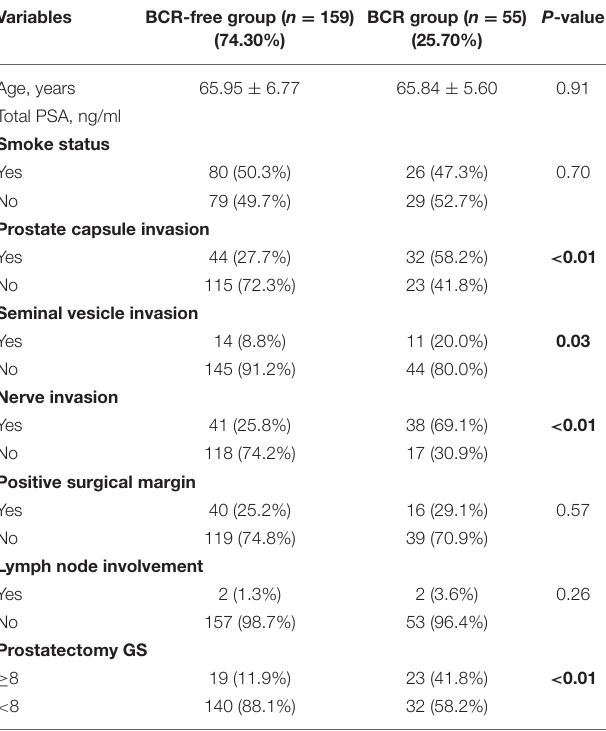
TABLE 3 | Association between BCR and clinicopathological factors. Variables